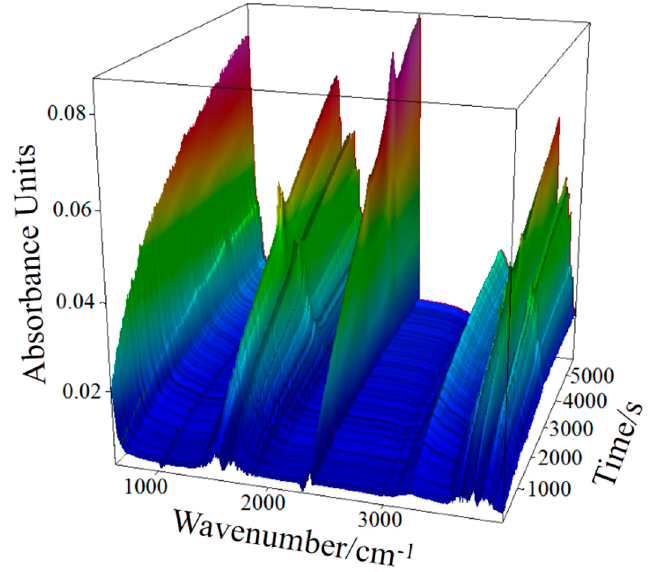
Figure 4. Infrared spectra of gas released from high–sulfur bauxite with a heating rate of 15 °C/min.